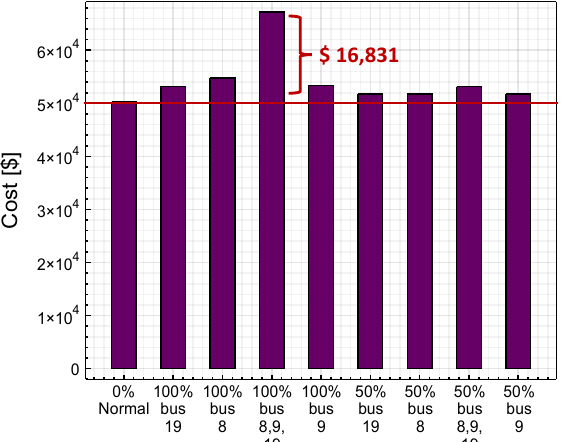
Figure 6. Optimal power flow (OPF) costs for the nine scenarios